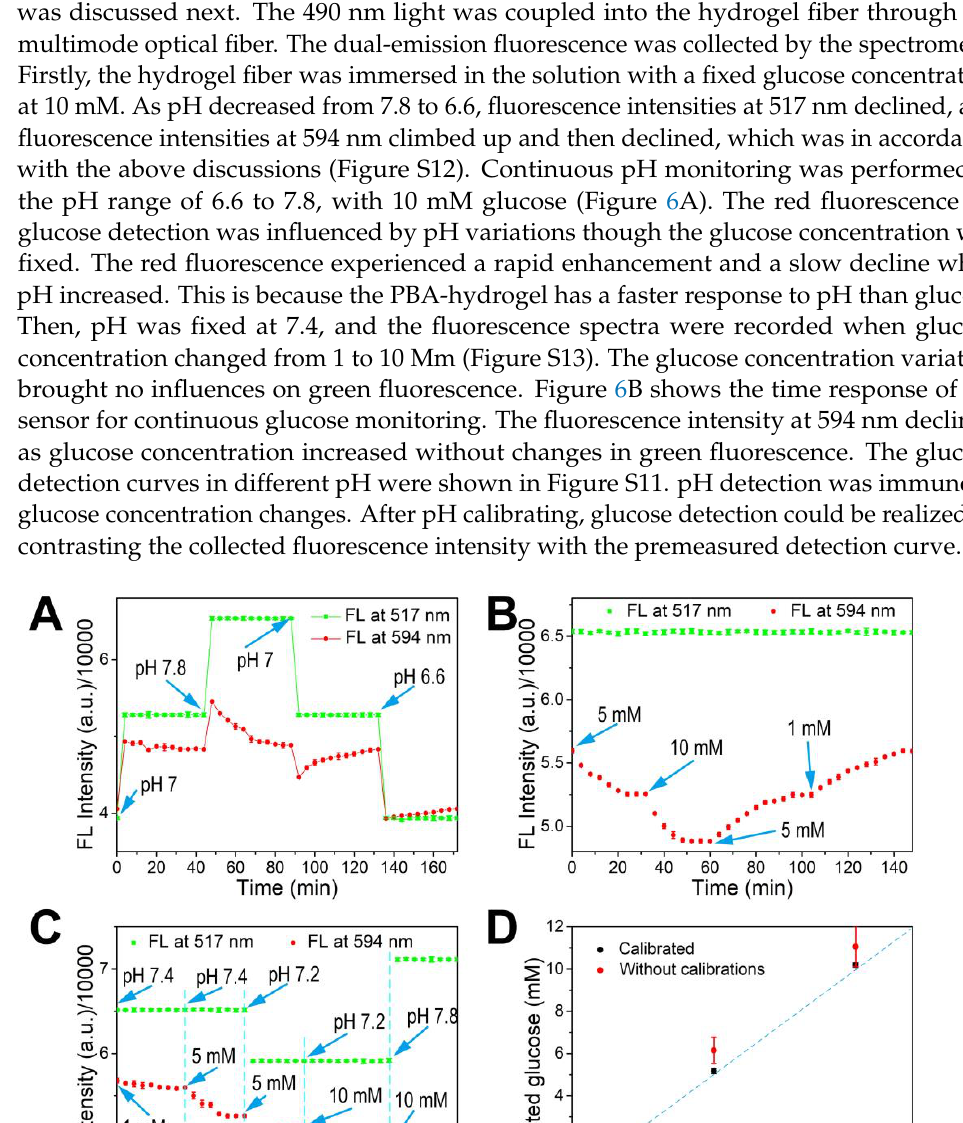
tion curves measured before. Figure 6D shows the detected glucose in comparison with the actual glucose concentration. The deviation was less than 3%. Without calibrated re- sults, pH changes would bring large deviations (>10%) and significant fluctuations in glu- cose monitoring. Thus, pH calibration is necessary for pH-sensitive glucose sensors. The sensor performed well in simultaneous continuous glucose and pH monitoring when pH